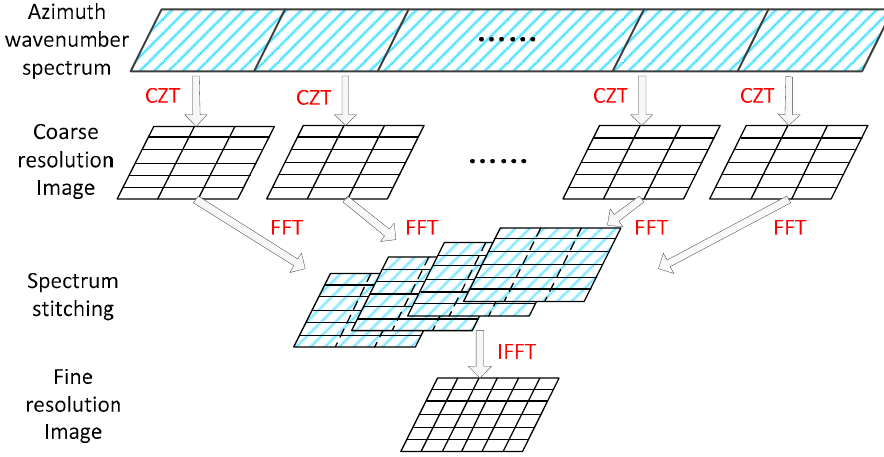
Figure 3. Schematic diagram of frequency domain back-projection algorithm (FDFBPA).